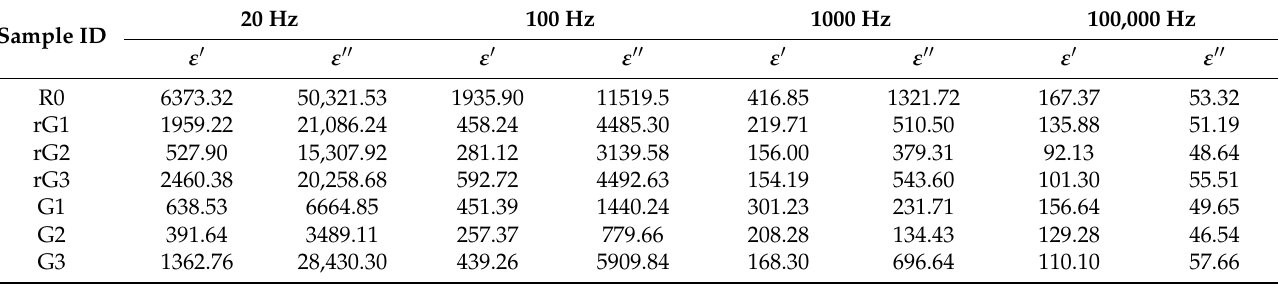
Figure 16. Dielectric constant of the samples with rGO ( a ) and GO ( b ) addition. Table 6. Dielectric constant and loss of the samples at specific